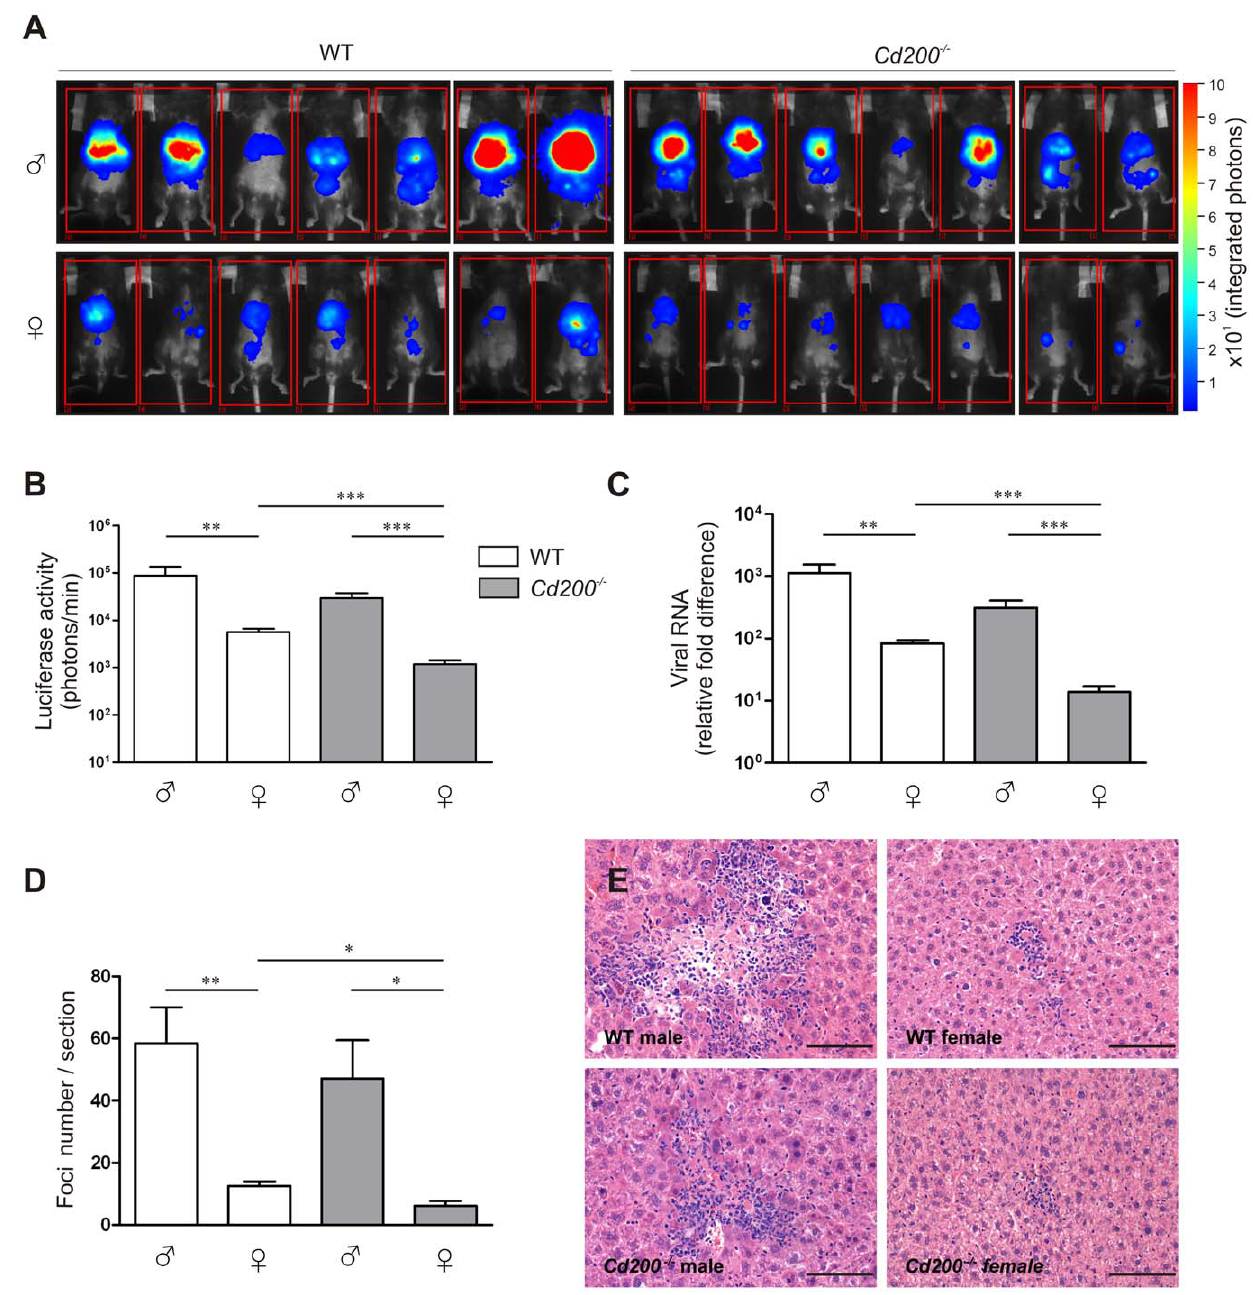
Figure 1. CD200-deficiency and sex determine the outcome of MHV infection. A Male and female WT (open bars) and Cd200 2 / 2 (gray bars) mice (n=7 per group) were intraperitoneally inoculated with CoV (MHV-EFLM). At day 4 after infection mice were injected intraperitoneally with luciferin and were subjected to BLI. Integrated light intensity is shown. Results are representative of three independent experiments. Uninfected mice did not give a BLI signal. B Quantification of the data in (A). C Four days after infection mice were sacrificed, RNA was isolated from livers and fold- difference in viral RNA was measured by qRT-PCR. D Livers from mice 4 days post-infection were fixed and stained with hematoxylin and eosin. Cellular infiltration foci were quantified in the whole liver sections, (n=7). In (B–D) mean 6 SEM is shown. Statistical significance was calculated with a Mann-Whitney test. ns=not significant. *=p , 0.05. **=p , 0.01. ***=p , 0.005. E Representative example of single foci from livers of mice 4 days after infection, (n=7). Similar results were obtained in 3 independent